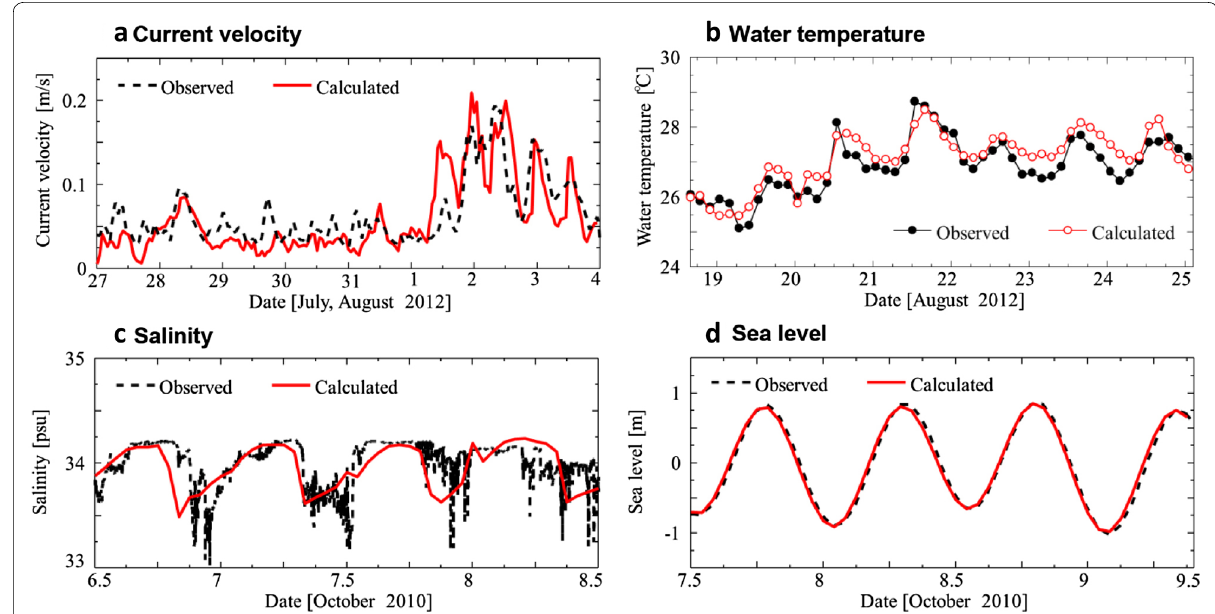
Fig. 8 Comparison between observed and calculated values (after Fig. 11 in Shimokawa et al.